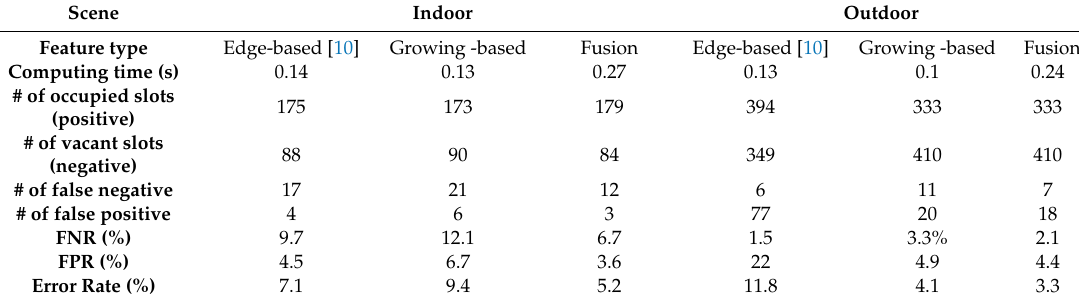
Table 6. Indoor and outdoor space occupancy classification rates. FNR—false negative rate;